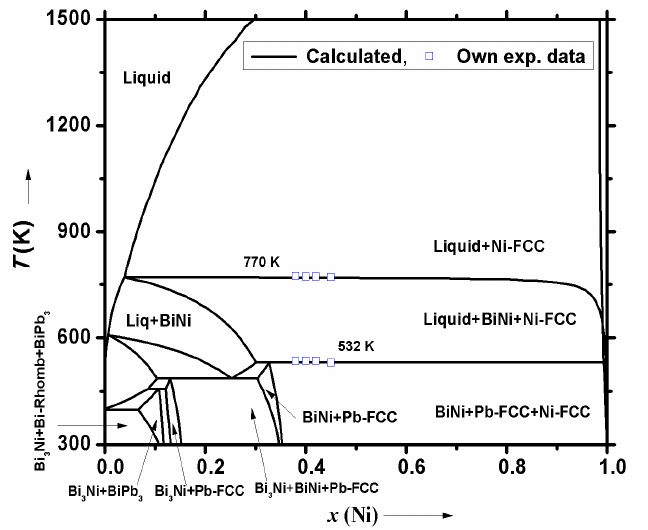
Figure 4. Calculated isopleth for pseudo binary of LBE-Ni (Bi 0.55 Pb 0.45 -Ni) and comparison with DTA results.